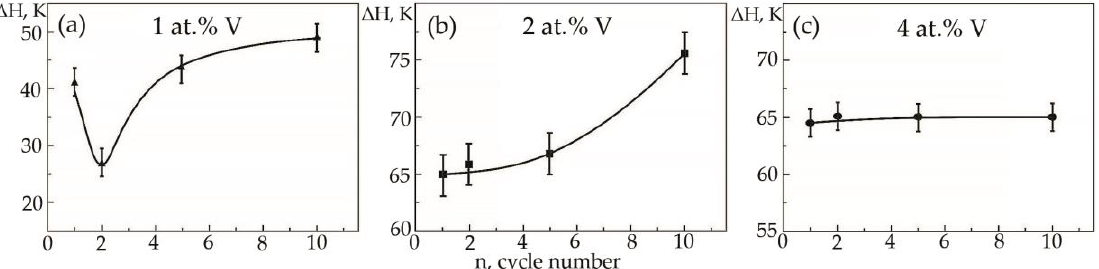
Figure 15. Width of the hysteresis loop on the temperature dependence of deformation under constant load on the cycle number in alloys: ( a ) — No. 1; ( b ) — No. 2; ( c ) — No. 3.